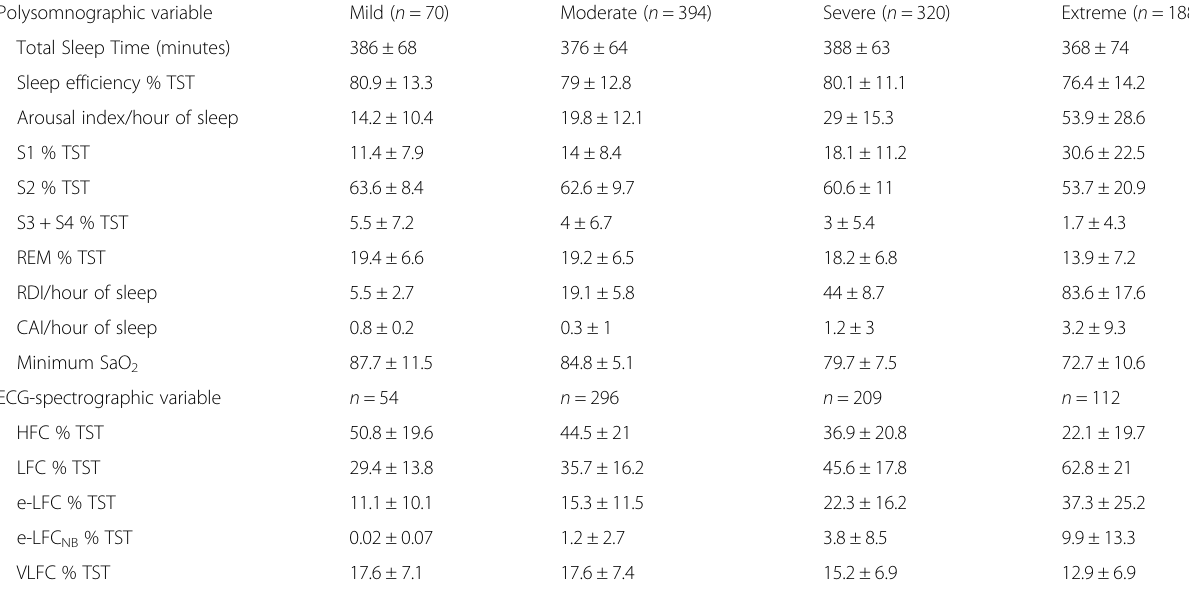
baseline including all cognitive measures did not show NREM vs. REM dominance: 9.2 ± 4.2 vs. 10.2 ± 4.3, t - Table 5 Polysomnographic and spectrographic metrics across apnea severity groups (mean ± SD) Polysomnographic variable Mild ( n =